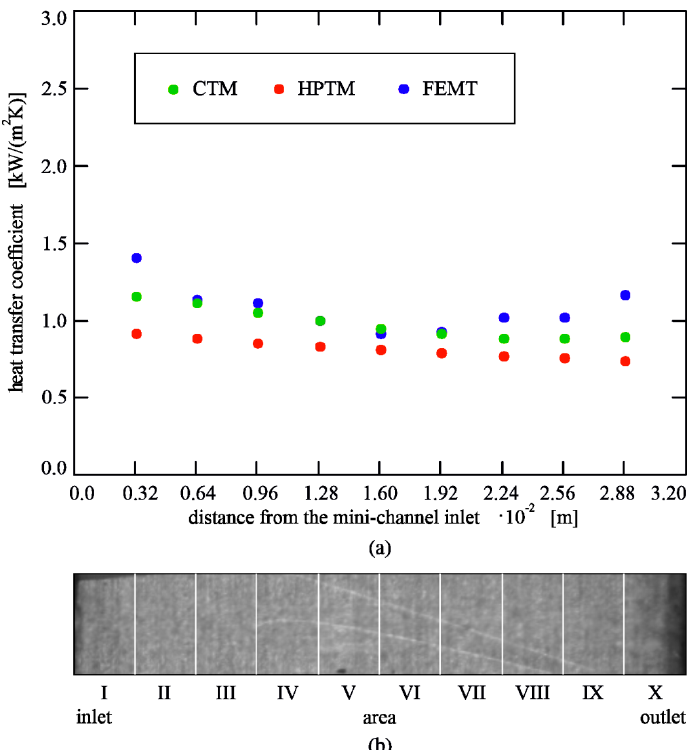
Figure 6. ( a ) Heat transfer coefficient versus distance from the mini-channel inlet, ( b ) two-phase flow pattern, t = 340 s; other experimental parameters are listed in Table 1. Energies 2021 , 14 , x FOR PEER REVIEW